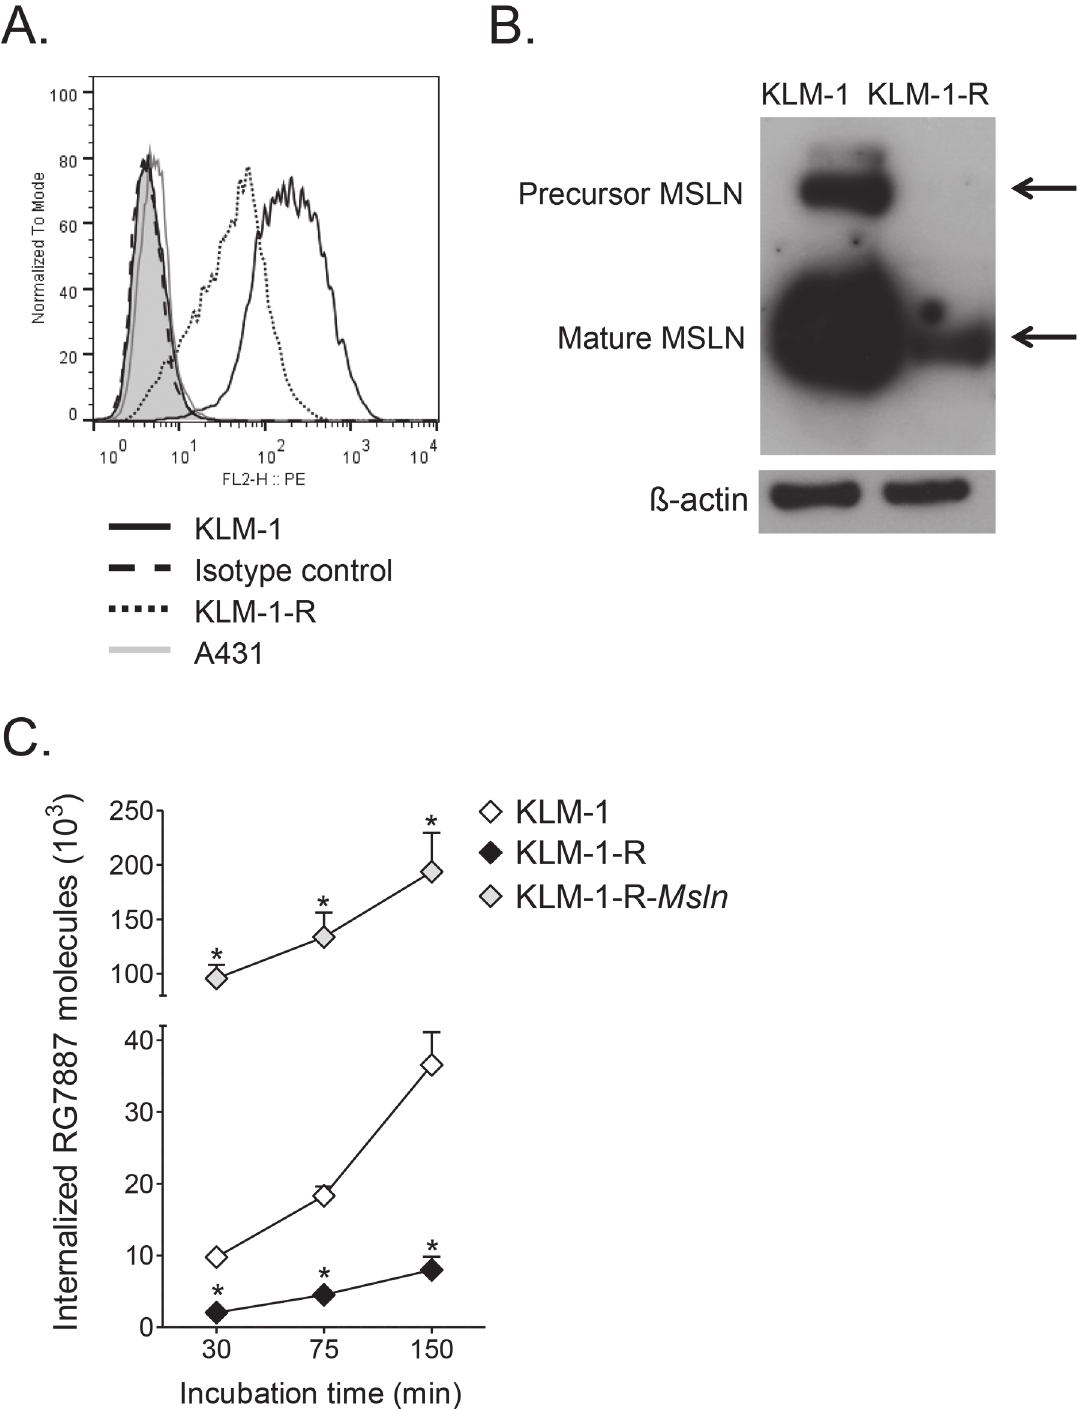
Fig 2. Mesothelin expression and RG7787 uptake is decreased in KLM-1-R. A : Surface mesothelin levels are 5-fold lower in resistant KLM-1 (KLM-1-R) compared to KLM-1. Mesothelin expression of KLM-1, KLM-1-R and mesothelin-negative A431 cells (negative control) were evaluated using flow cytometry. Filled histograms are secondary antibody controls. B : Whole mesothelin protein level is decreased in KLM-1-R. Precursor (72 kDa) and cleaved mature mesothelin (37 kDa) were present in KLM-1. In KLM-1-R, the cleaved portion was detected at low levels. Protein levels were probed in untreated KLM-1 and KLM-1-R cell lysate by Western blot. β -actin acts as loading control. C : At each time point, cellular uptake of RG7787-Alexa647 in KLM-1 is significantly higher than in KLM-1-R, and significantly lower than in KLM-1-R- Msln (transfected with mesothelin). Uptake was evaluated at 30, 75 and 150 min. Average geomean fluorescence intensities converted into amount of RG7787 molecules.